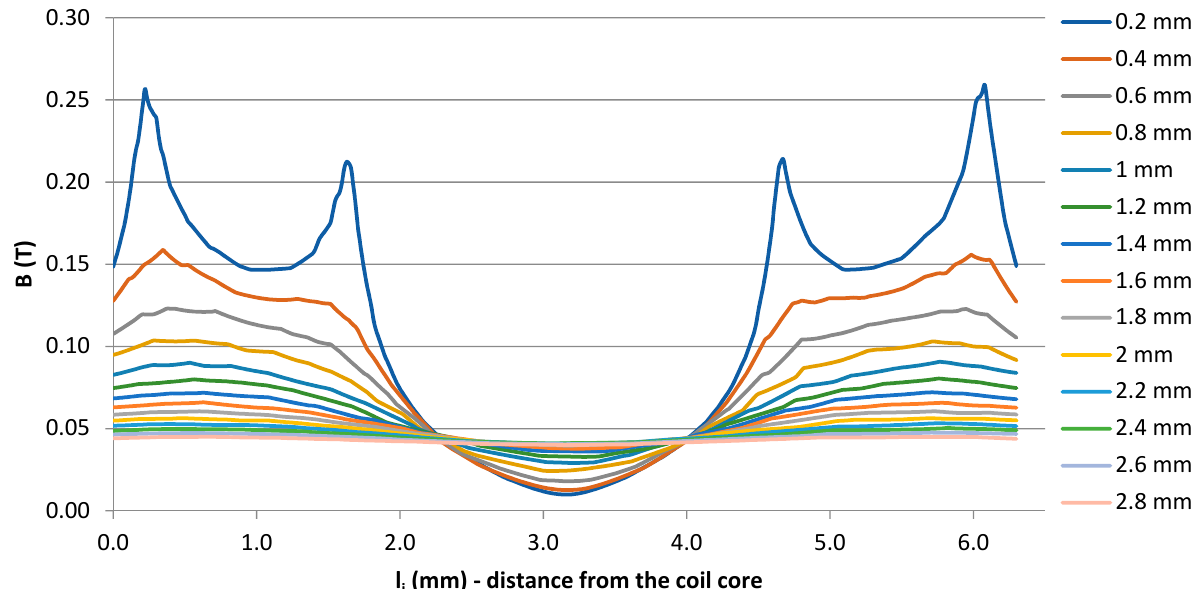
Figure 13. Magnetic induction distribution along the outer diameter of the air gap of the inductor described by situation Figure 12a.